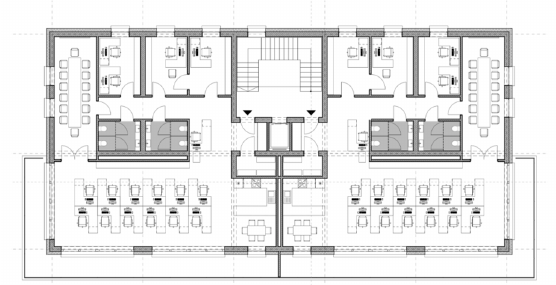
Figure 1. Repetitive floor plan, shown for office use, including: reception hall, secretariat, director’s room, accounting room, conference room, office space, kitchen with dining annex, men’s and ladies’ room, archive room or cloakroom near the entrance.